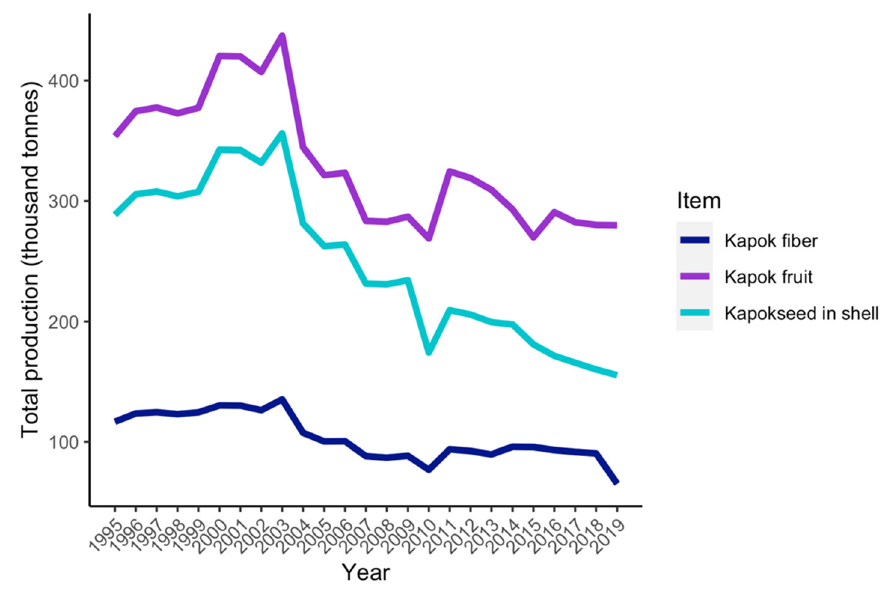
Figure 1. FAO estimates of worldwide production of kapok fiber, fruits and seeds since 1995. The data correspond to the combined production of Indonesia and Thailand, the only countries indicated in the database.